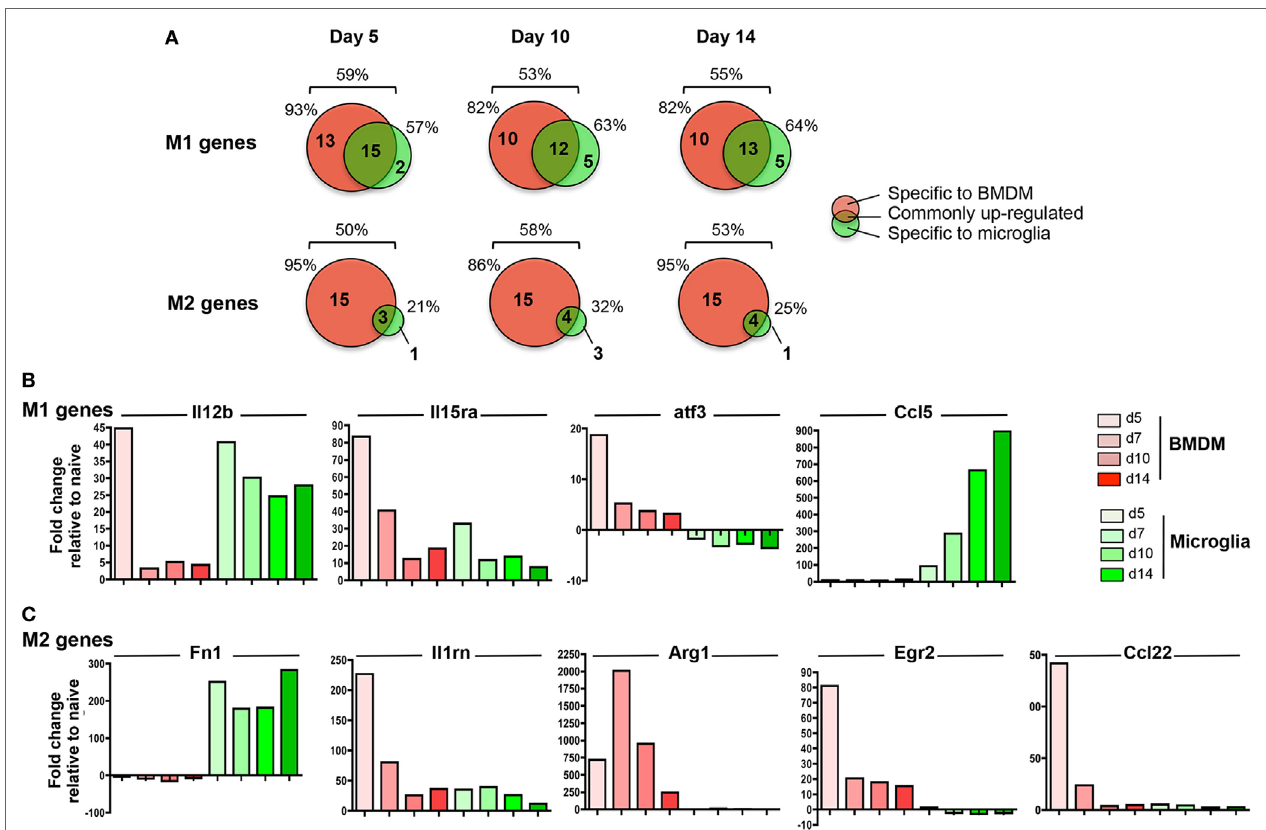
FigUre 8 | M1 and M2 gene regulation following JHMV infection. bone marrow-derived macrophage (BMDM) and microglia gene expression patterns obtained from infected mice described in Figure 4 were analyzed for (a) the number and distribution of M1 and M2 genes upregulated specifically in one or both populations at days 5, 10, and 14 p.i. Percentages above each diagram represent the overall proportion of M1 or M2 genes upregulated at each time point, while percentages on each side of the diagram represent the proportion of regulated genes with increased expression in BMDM versus microglia. The fold expression change of (B) select M1 genes (Il12b, Il15ra, atf3, Ccl5) and (c) select M2 genes (Fn1, Il1rn, Arg1, Egr2, Ccl22) compared to naïve levels within microglia and BMDM between days 5 and 14 p.i. is represented in bar